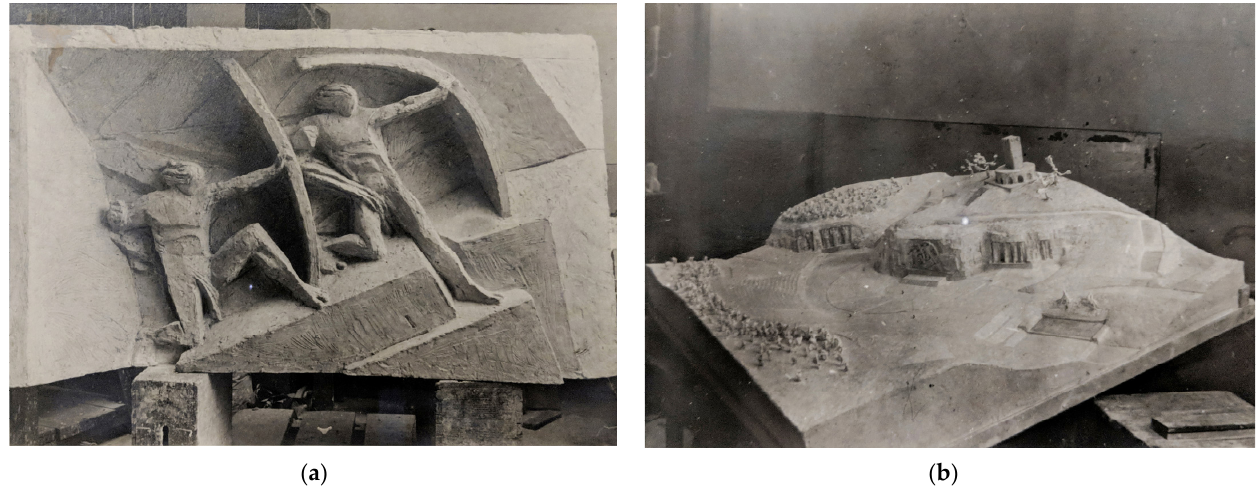
Figure 4. Saint Anne Mountain, the first competition for the design of the monument commemorating the Silesian Insurgents. Xawery Dunikowski’s work (in cooperation with W ł adys ł aw Jarocki and Franciszek M ą czy ń ski), with models of ( a ) the reliefs of the Slavic archers and ( b ) the entire complex (National Museum in Warsaw, Królikarnia).